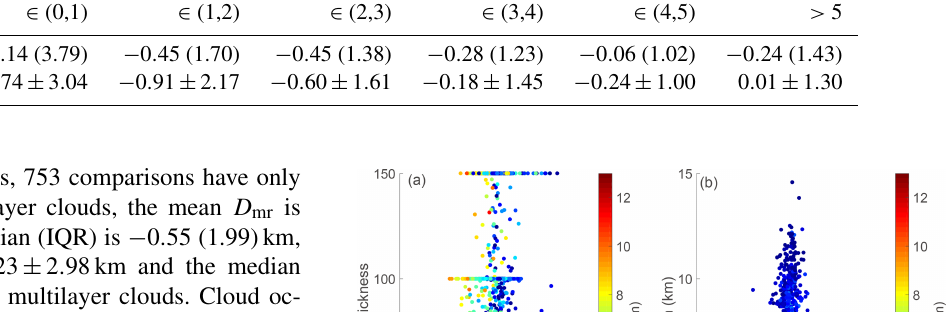
Figure 9. Statistical results of comparisons between Ka radar and AHI. Panel (a) shows the Ka radar CTHs and the AHI CTHs of all comparisons. Panel (b) is the same as Fig. 6b but for the D ar . (c) The mean D ar and the STD changes with CD. (d) The median of D ar and IQR changes with CD. Table 2. The median (IQR), mean and standard deviation of D mr with different CDs (mean ± STD) (unit: km). CD